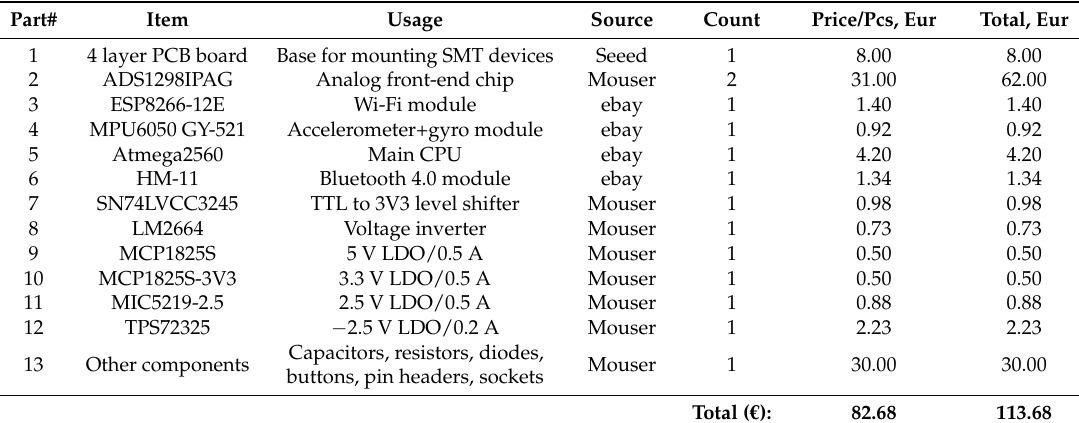
Table 4. Bill of materials of a single EEG